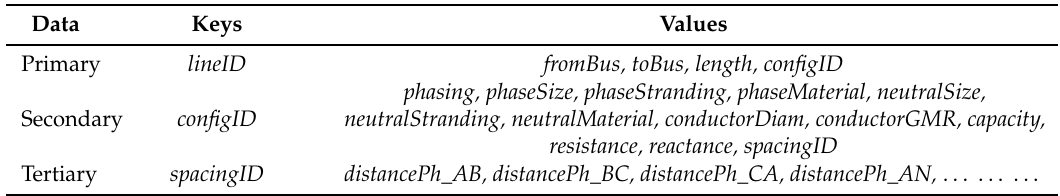
Table 1. Sample data structure relating to distribution lines.